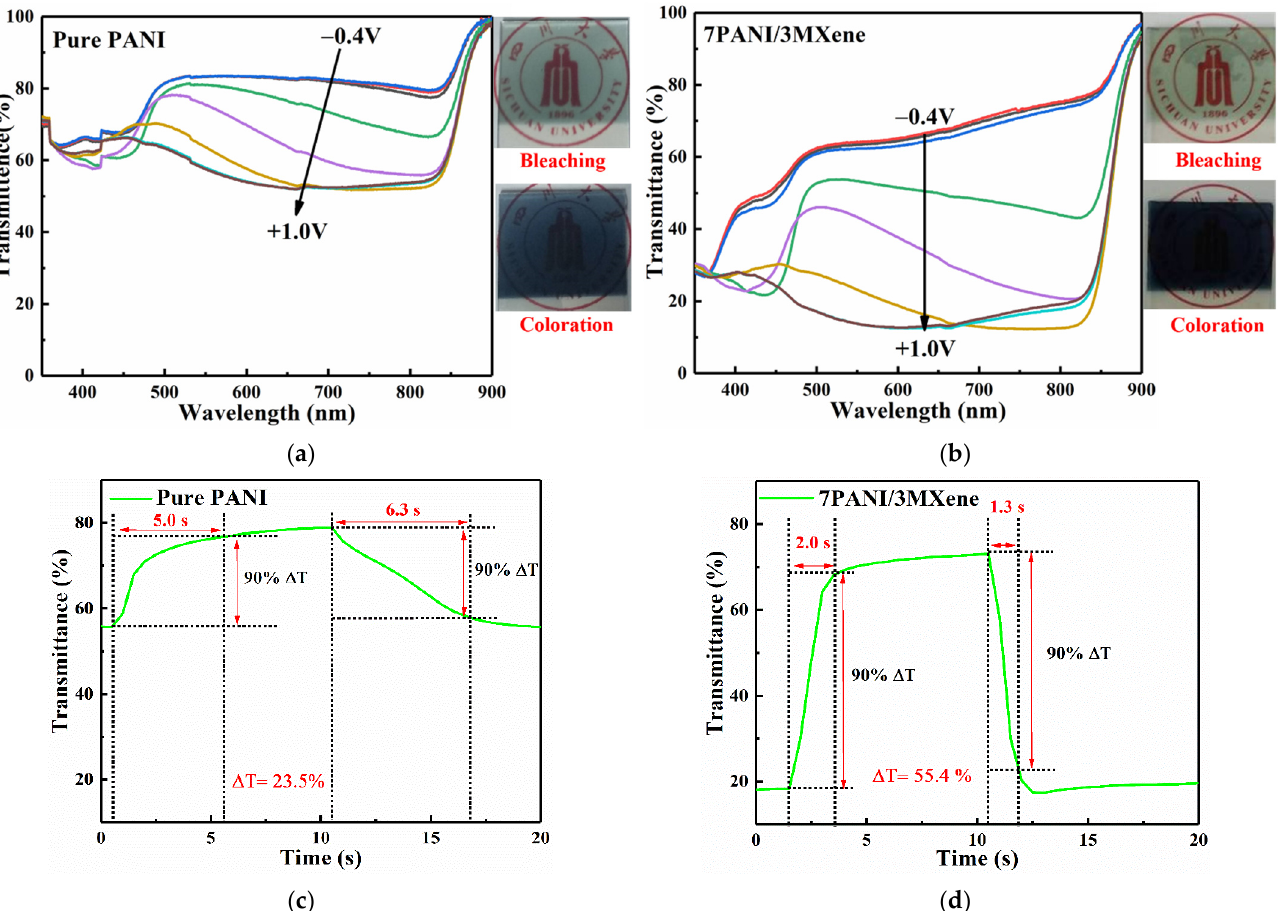
Figure 6. ( a , b ) UV—vis transmittance spectra of Pure PANI and PANI/MXene films performed at different applied potentials. The curves of different colors correspond to the UV—vis transmittance spectra of the films under different constant voltages ( − 0.4 to +1.0 V). ( c , d ) In situ optical transmittance responses of PANI and PANI/MXene with applied potentials of − 0.4 and +1.0 V for 10 s per step measured at 700 nm.